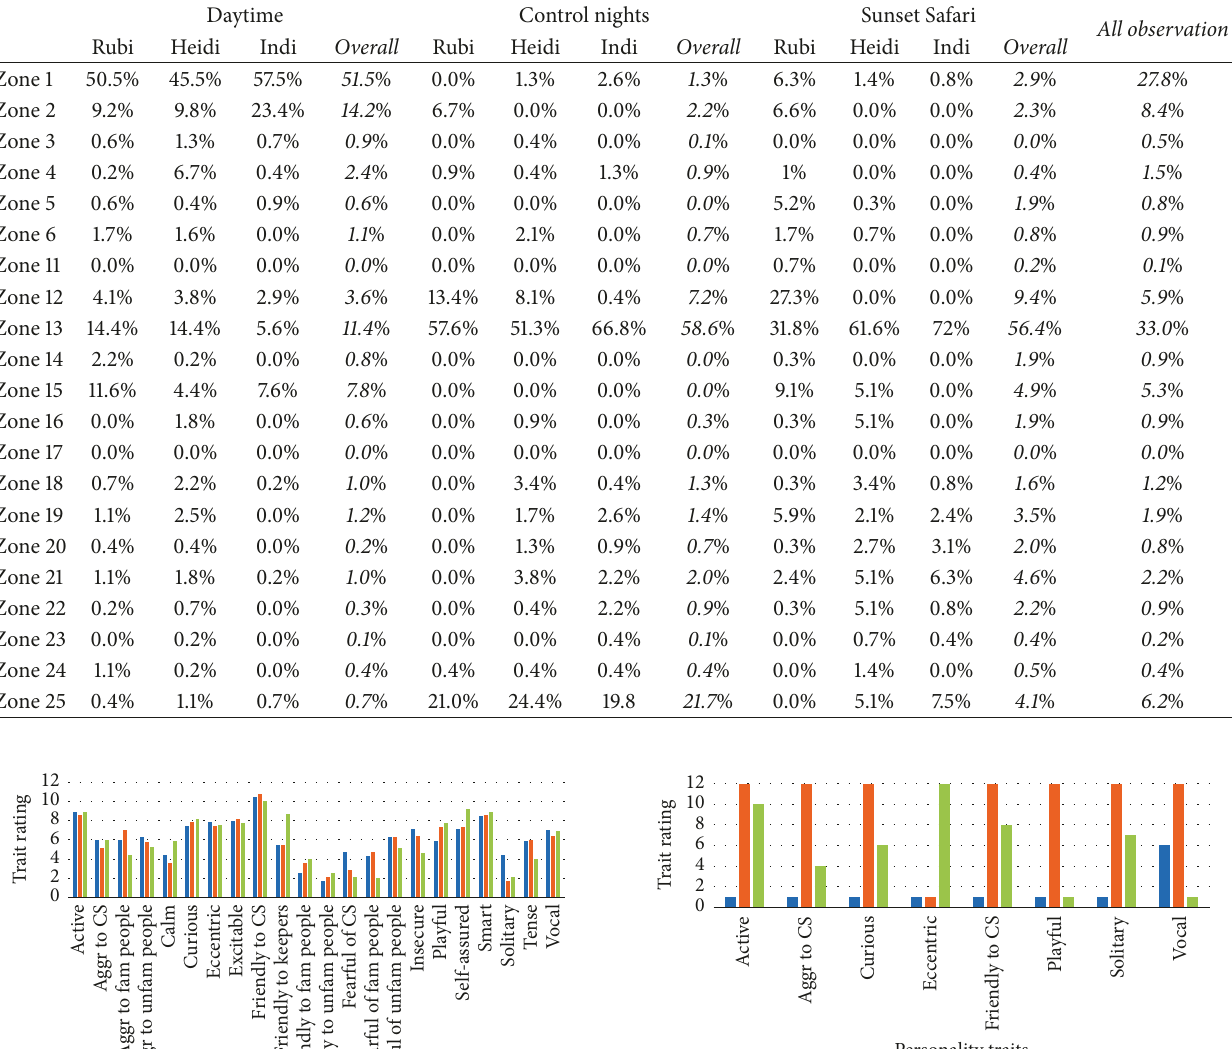
Table 4: Enclosure use values at London Zoo for each female and overall for each observation period, and in total for all observations. Daytime Control nights Sunset Safari Rubi Heidi Overall Rubi Heidi Overall Rubi Heidi Overall